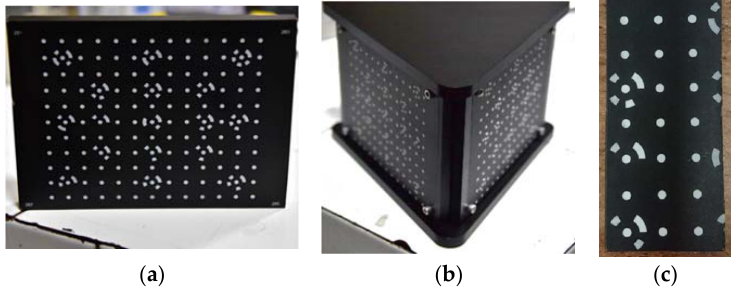
Figure 2. The three types of calibration targets: ( a ) the plane standard target; ( b ) the triangular prism standard target; ( c ) the small target.